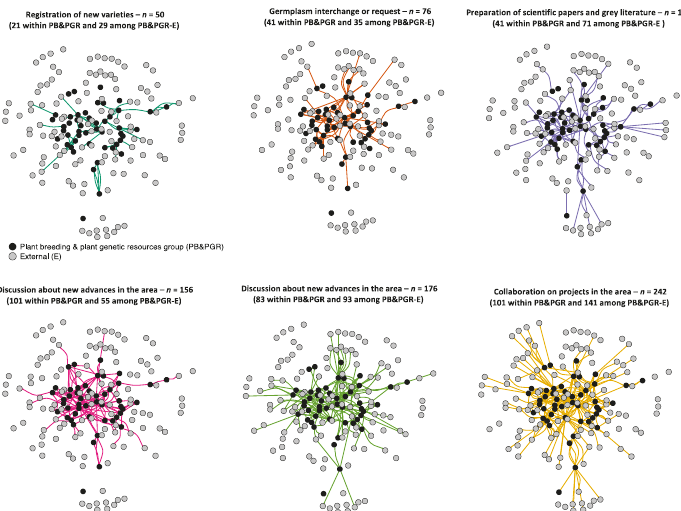
Figure 8. The six types of interactions among 50 researchers from the plant breeding and plant genetic resources group (PB&PGR) in black and 117 externals (including other disciplines within A GROSAVIA and outside institutions) (E) in grey. The six types of interactions are listed from the lowest number of total connections in the top left to the highest number of total connections in the bottom right. The number of interactions for researchers within the PB&PGR group and for researchers between the PB&PGR and externals is given in parentheses for each interaction type. The dots represent the researchers (i.e., vertex in the network), and the lines represent the interactions (i.e., edges in the system).